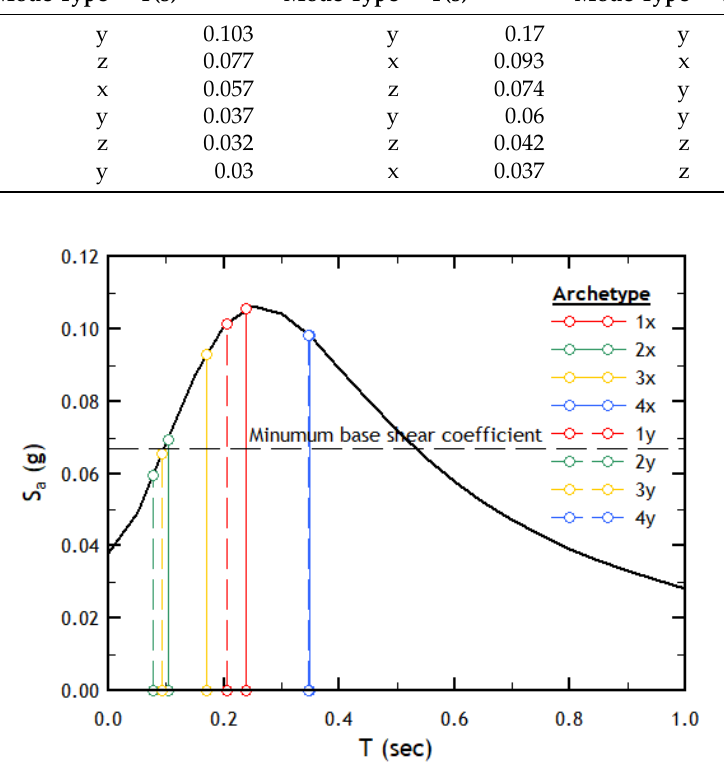
Figure 9. Inelastic design spectrum with the predominant structural periods in the directions of analysis.